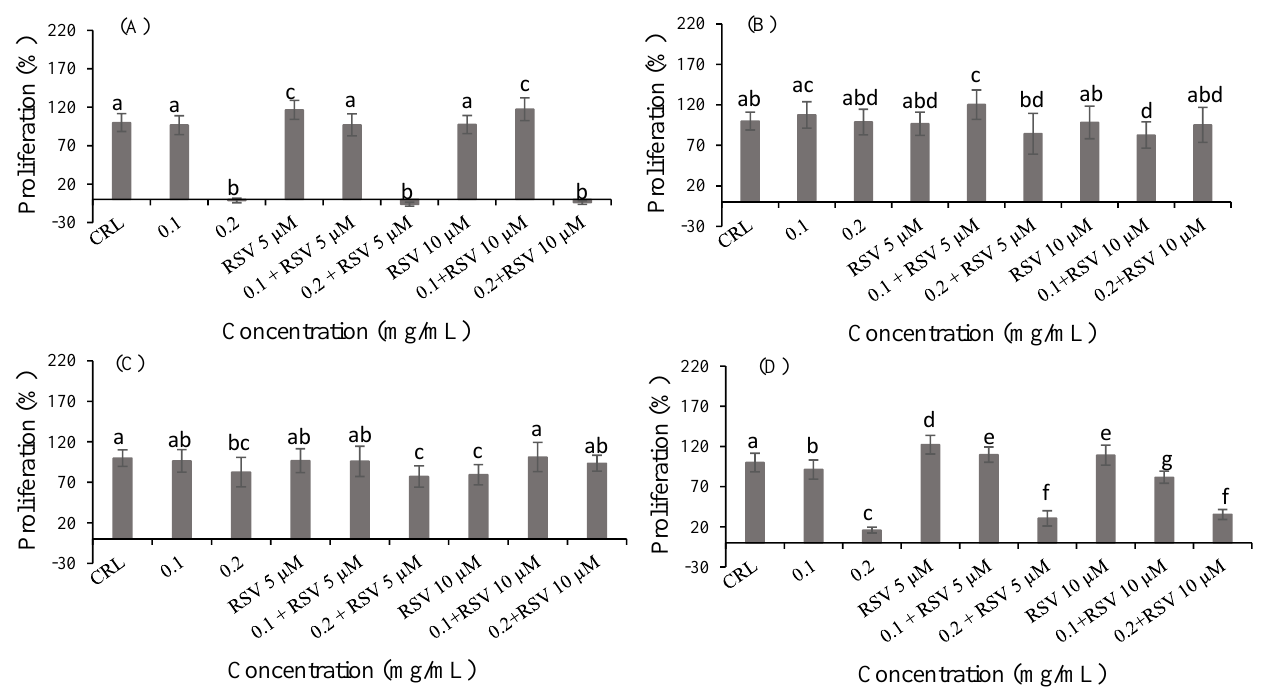
Figure 5. Protective effect of RSV (10 and 25 µM) on the bioaccessible fractions (0.1 and 0.2 mg/mL) of product 1 ( A ), product 2 ( B ), product 3 ( C ) and collagen ( D ) in Caco-2 cells after 24 h of exposure as assessed by the MTT assay. Values are expressed as mean ± SEM ( n = 3). Values in the same figure with different superscript letters are significantly different ( p < 0.05). CRL: control; RSV: